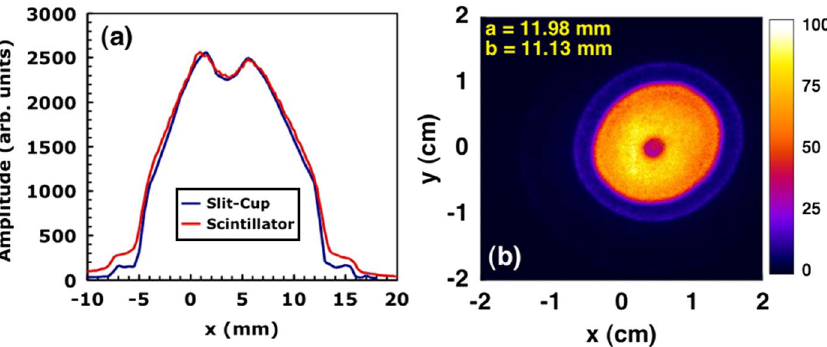
FIG. 12. (Color) Transverse profile of the beam measured: (a) 50 cm ( z (cid:6) 181 cm ) and 56 cm ( z (cid:6) 187 cm ) downstream of the exit of two solenoids. (b) Transverse beam distribution at the scintillator plane. All integrated over a 500 ns gate in the middle of the 10 (cid:1) s beam pulse.